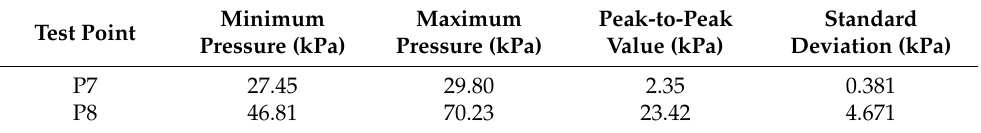
Table 3. Pc = 5.78 MPa. Data statistical analysis results.